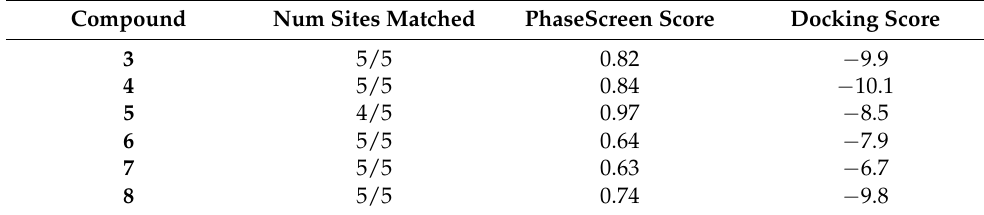
Figure 8. Docking poses of 3 (panel A ), 4 (panel B ), 6 (panel C ) , 7 (panel D ) , and 8 (panel E ) in the “pharm-sEH” onto the sEH binding site (PDB code: 5AI5). Table 1. Parameters of 3 – 8 compounds after pharmacophore